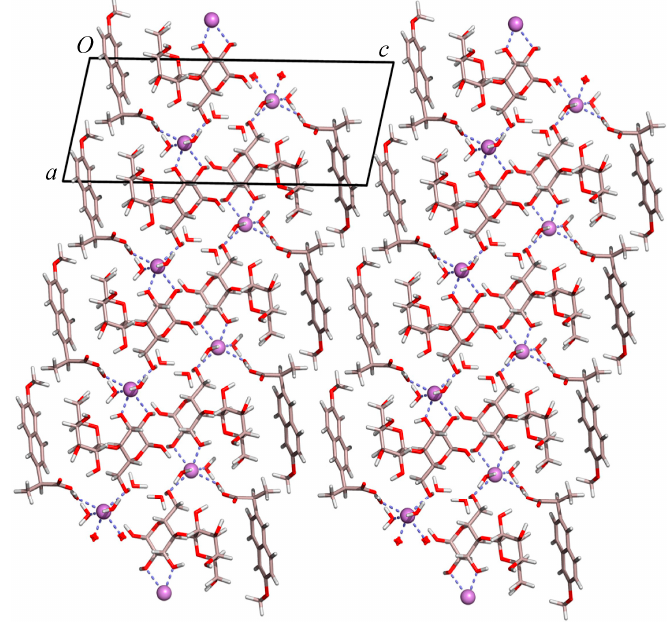
Figure 2. The crystal packing of NaN-Lact-4H 2 O, showing the water molecules included in the chains along the b axis; color code: Na-purple, O-red, C-light pink, H-white.